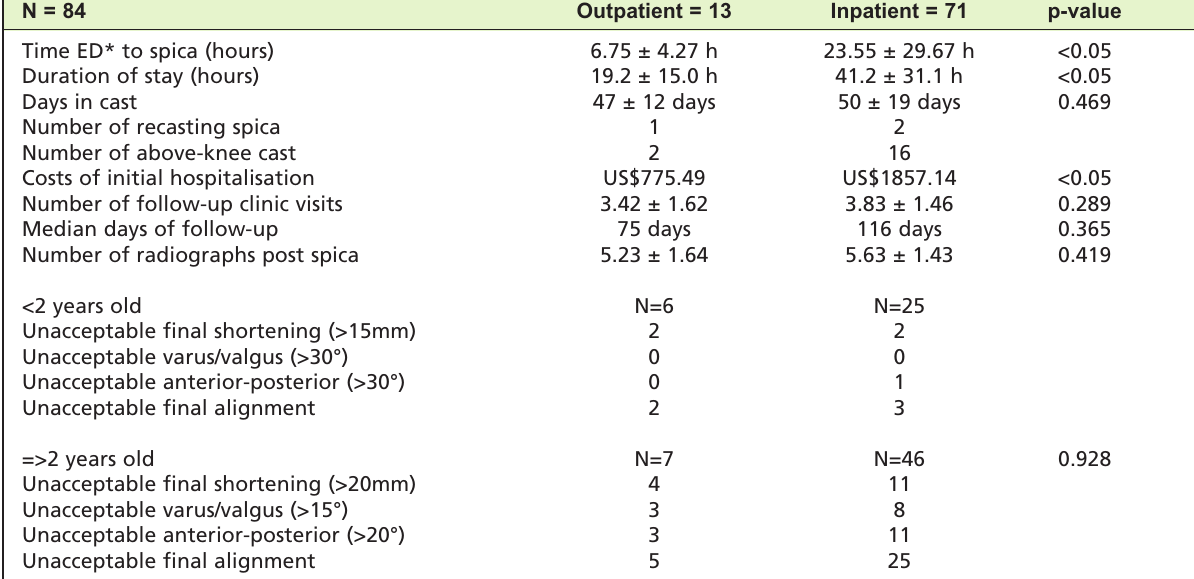
Outcome variables of displaced femoral shaft fractures between inpatient and outpatient cohorts Table II: N = 84